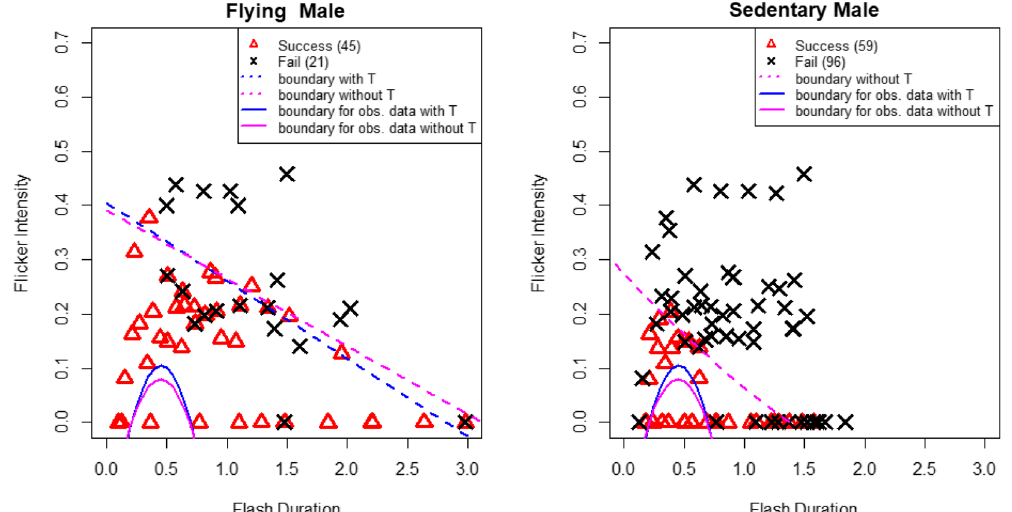
Figure 3. Successes (red dots) and failures (black cross) of attraction of flying males (left panel) and sedentary males (right panel) by e-firefly, with estimated discriminant boundaries for p = 0.5 . The blue dashed line is the estimated discriminant boundary by the model with temperature, and the magenta dashed line is that by the model without temperature. As references, the discriminant boundaries of receptive females from others for p = 0.5 for the observational data are drawn in solid curves (see Fig. 1). The coordinate values of all points are shown in Supplementary Data